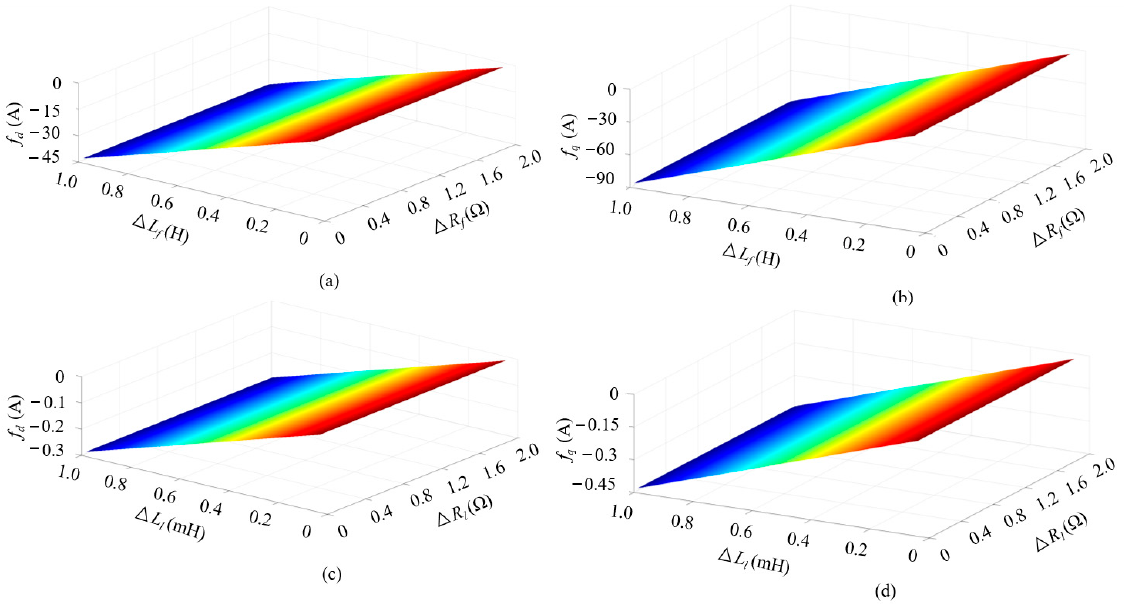
Figure 4. Relationship between the current estimation errors and the parameter variations. ( a ) Relationship between d -axis current estimation errors and ∆ R f , ∆ L f ( ∆ R l = ∆ L l = 0). ( b ) Relationship between d -axis current estimation errors and ∆ R l , ∆ L l ( ∆ R f = ∆ L f = 0). ( c ) Relationship between q -axis current estimation errors and ∆ R f , ∆ L f ( ∆ R l = ∆ L l = 0). ( d ) Relationship between q -axis current estimation errors and ∆ R l , ∆ L l ( ∆ R f = ∆ L f = 0).